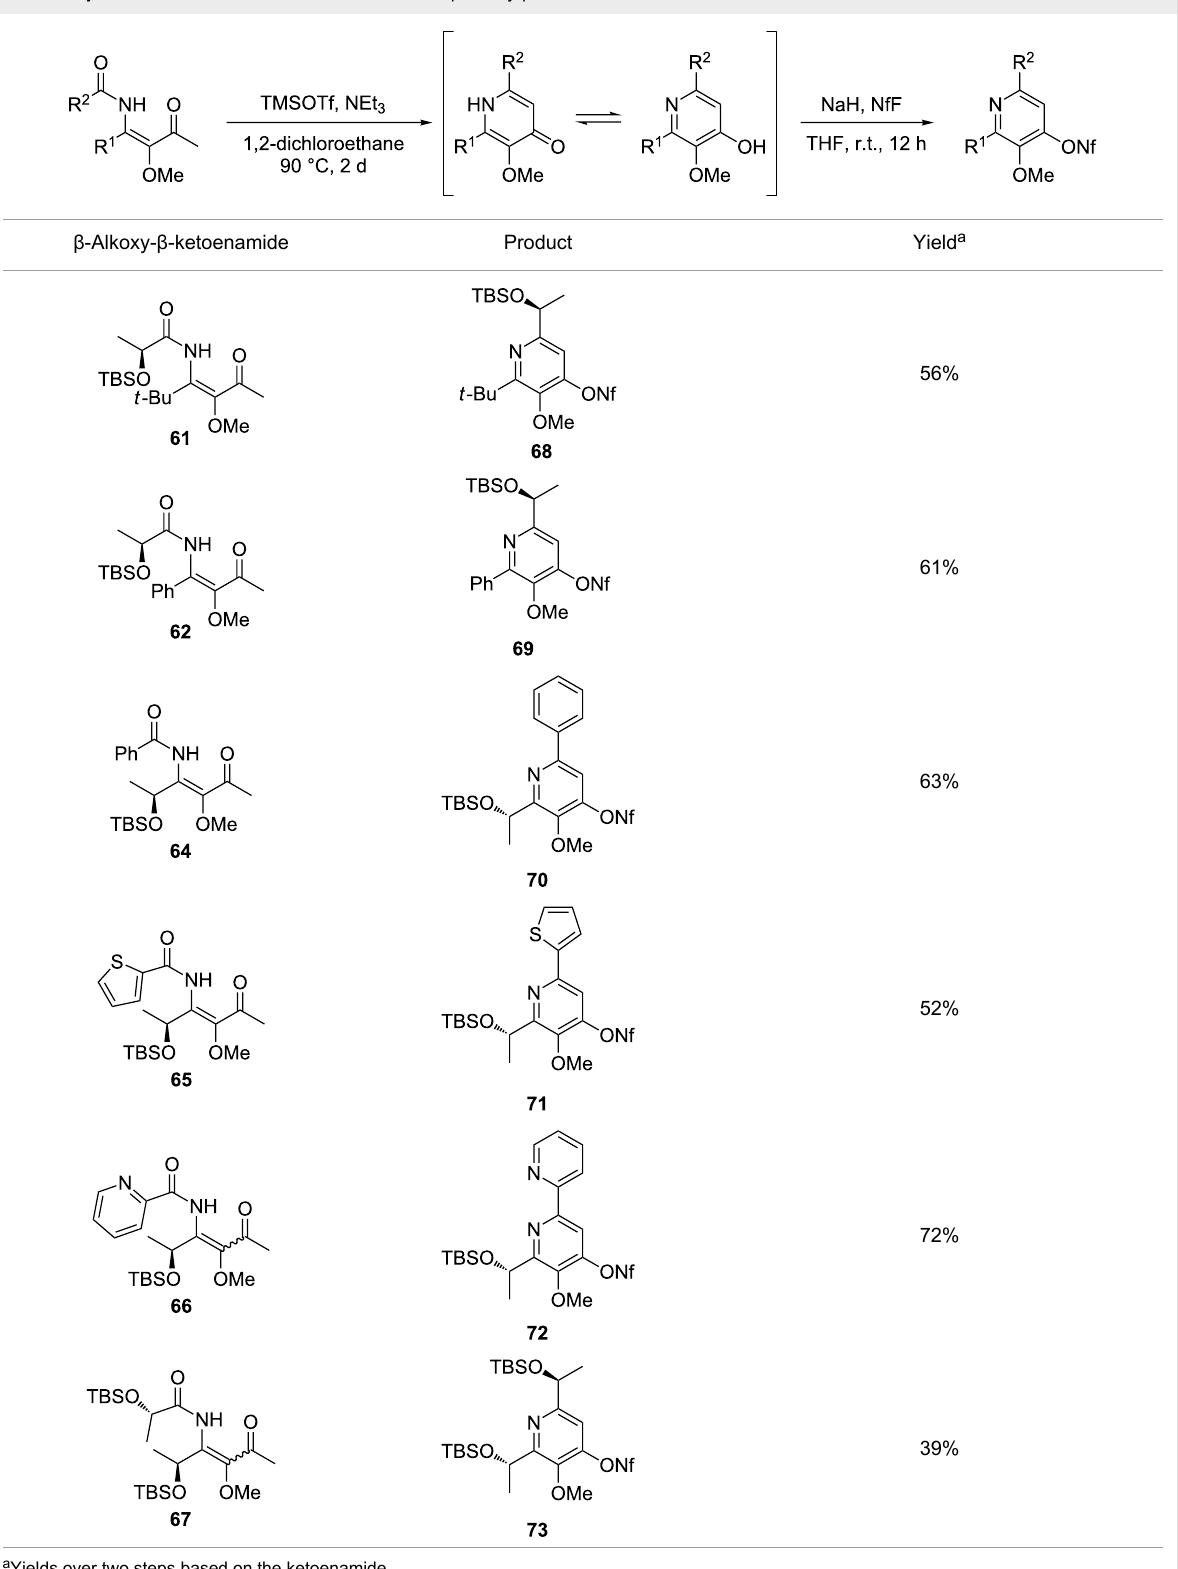
Table 4: Cyclization and nonaflation of lactic acid derived β -alkoxy- β -ketoenamides.